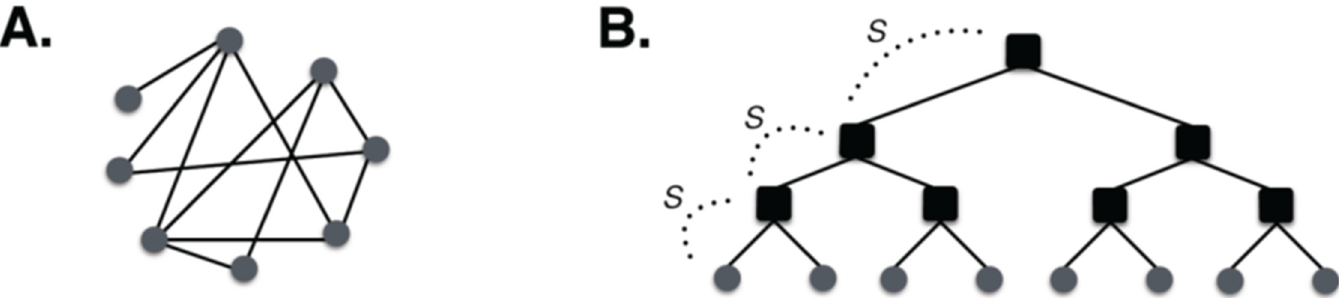
Fig 1. Schematic Social Networks of Towns and Cities. (A) An unstructured network where anyone can in principle connect with anyone else, subject to limitations deriving from cost of movement. Such a network is characterized by increasing connectivity with city population size, with mean degree N δ , δ * 1/6. (B) A structured socioeconomic network. In this case, interactions between individuals are regulated by social groups and institutions k ( N ) = k 0 (black squares) and may be damped by a factor s < 1, for each level of institutions involved. If the parameter s < 1, the net effect of institutions is to weaken social possibilities and thus reduce agglomeration effects, taking the exponent of the scaling of area with population for settlements closer to